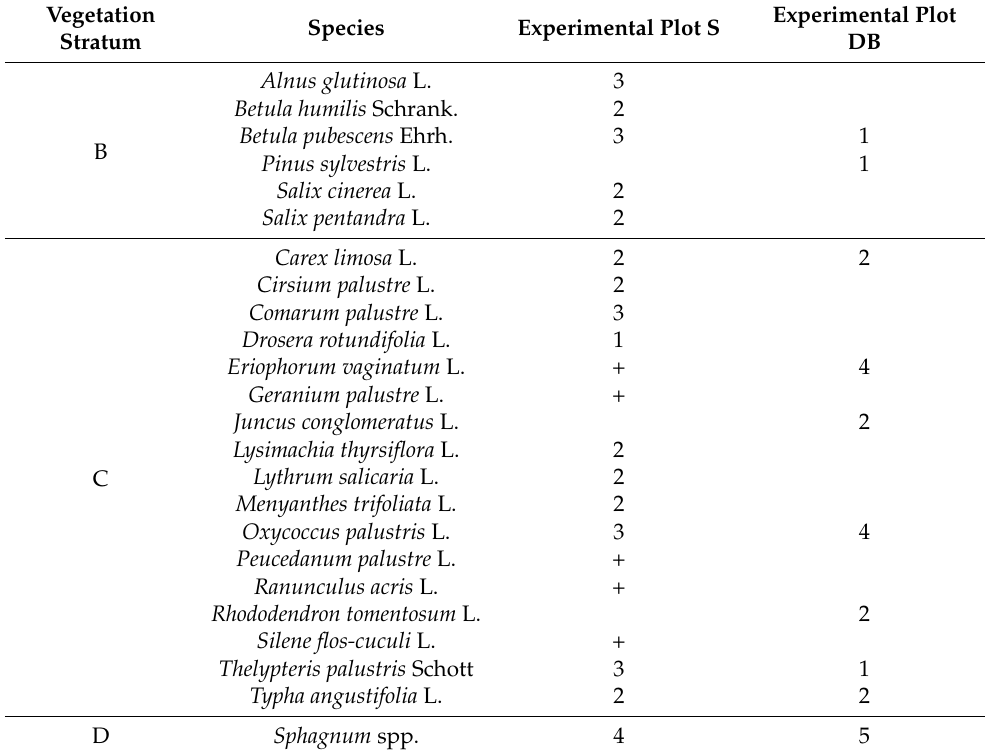
Experimental Plot DB